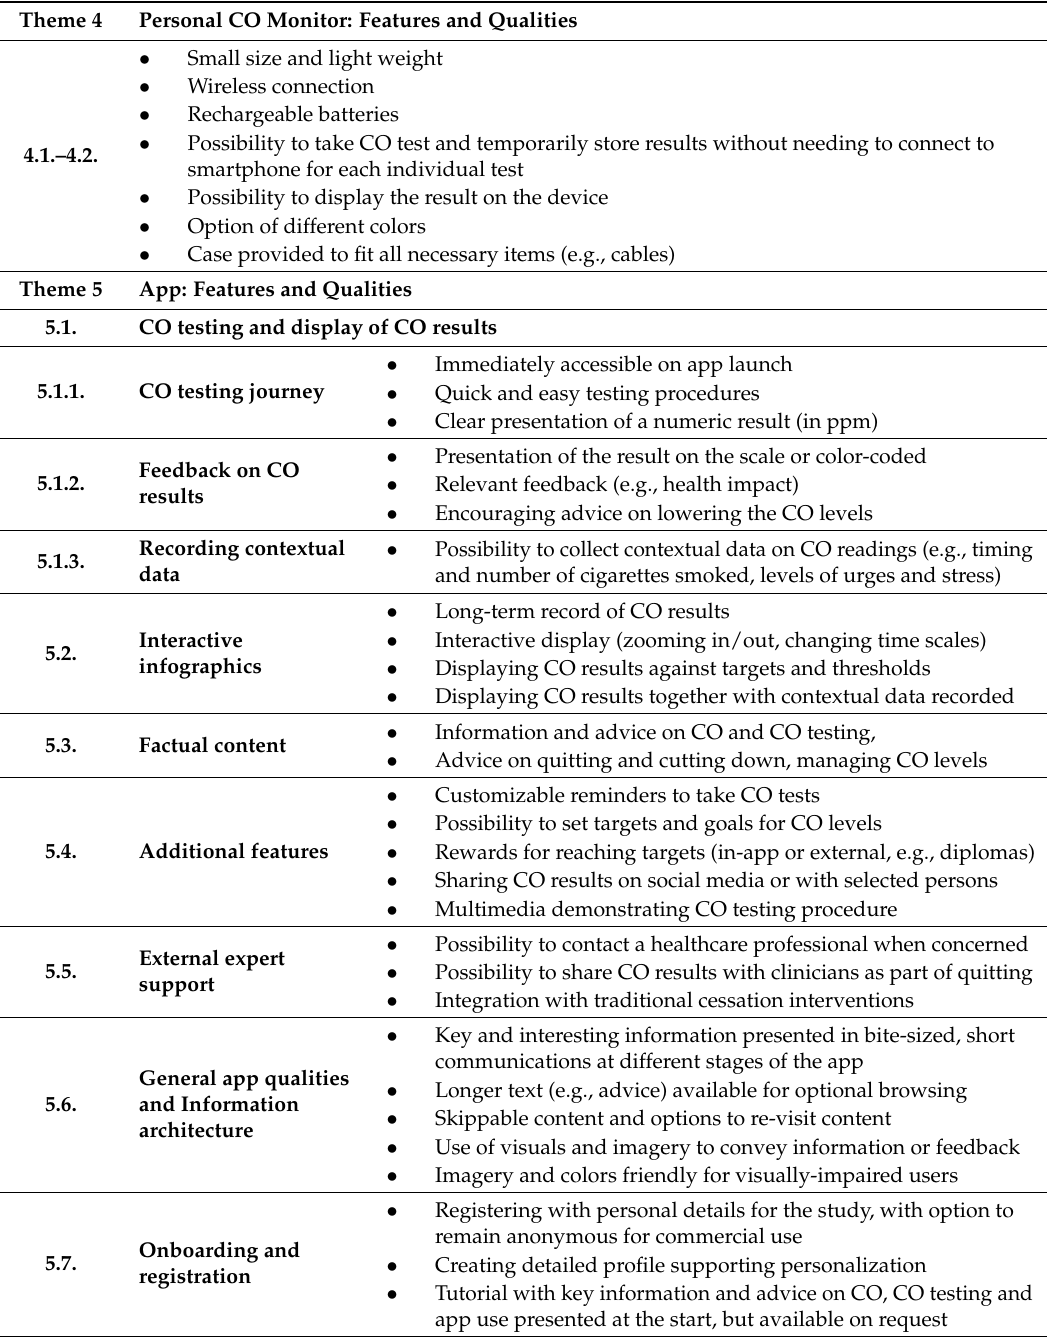
Table 3. Design suggestions for personal CO monitoring devices and associated